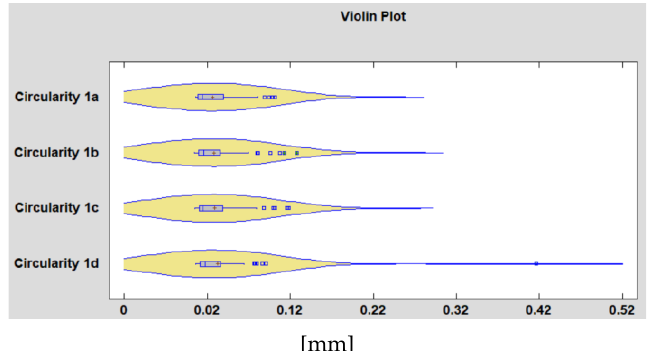
Figure 5. Comparative violin plot showing the measured values for the four holes on the sample’s P1 measurement plane’s deviation from circularity.